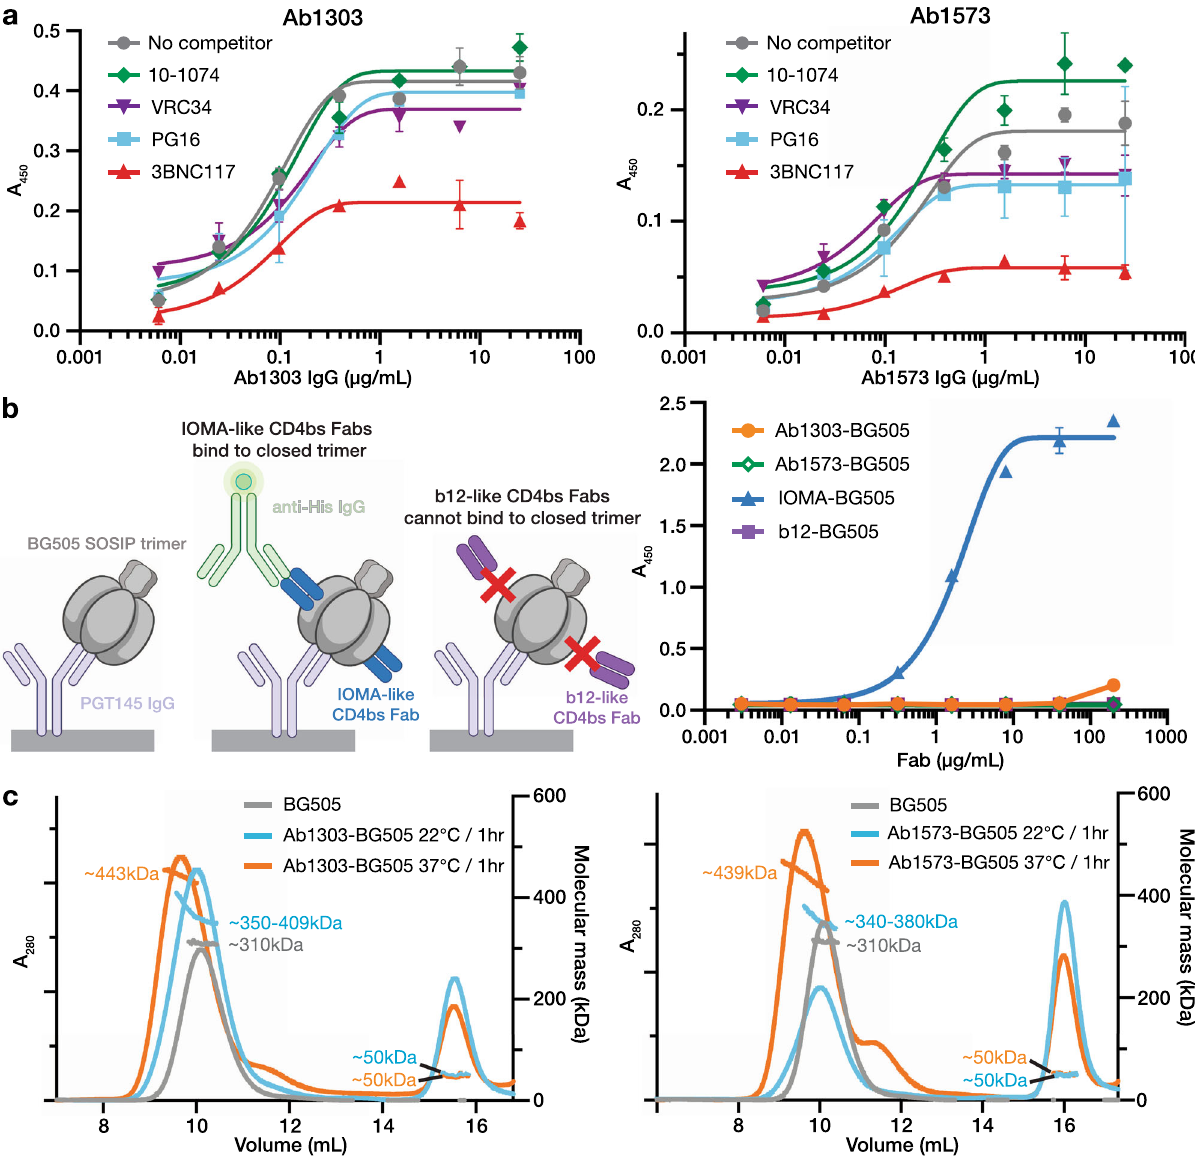
Fig. 1 Ab1303 and Ab1573 are CD4bs NAbs that bind an Env conformation other than the closed, prefusion state. a Competition ELISA to map the binding sites of Ab1303 (left) and Ab1573 (right) on BG505 SOSIP. Randomly biotinylated BG505 SOSIP trimer was immobilized on a streptavidin plate and then incubated with a Fab from a bNAb that recognizes the V3 loop (10-1074, green, diamonds), the fusion peptide (VRC34, purple, inverted triangles), the V1V2 loop (PG16, blue, squares), or the CD4bs (3BNC117, red, triangles). Increasing concentrations of Ab1303 or Ab1573 IgG were added to the Fab-BG505 complex, resulting in competition in both cases with the CD4bs bNAb 3BNC117. Data represents mean ± s.d. from n = 2 biologically independent samples. Source data are provided as a Source Data fi le. b ELISA to assess binding of Ab1303 and Ab1573 to closed, prefusion conformation of BG505 trimer. Left: schematic of the experiment: PGT145 IgG (light purple), which constrains BG505 to a closed prefusion conformation, was immobilized and captured BG505 (gray). Binding of His-tagged Fab (blue or dark purple) to BG505 was detected using a labeled anti-His-tag antibody (light green). Representation is created with BioRender.com. Right: Ab1303 (orange), Ab1573 (green), and b12 (dark purple) do not bind to BG505 captured by PGT145, but IOMA (blue) binds to BG505 captured by PGT145. Data represents mean ± s.d. from n = 2 biologically independent samples. Source data are provided as a Source Data fi le. c SEC-MALS of Ab1303-BG505 (left) and Ab1573-BG505 (right) complexes incubated at different temperatures. SEC traces were monitored by absorption at 280 nm. Traces and estimated molecular mass distributions for unliganded BG505 (gray) and for Ab1303 Fab or Ab1573 Fab incubated with BG505 SOSIP trimer at 37 °C (orange) or 22 °C (blue) for 1 h are shown. ELISA experiments conducted with RC1 trimer 19 , this time using BG505 trimer (Fig. 1a). We fi rst immobilized randomly- biotinylated BG505 Env trimers on streptavidin plates and then added antibody Fabs targeting either the CD4bs (3BNC117) 16 , the V3-glycan patch (10-1074) 29 , V1V2 (PG16) 30 , or the fusion peptide (VRC34) 31 . Subsequently, either Ab1303 or Ab1573 IgGs were added, the plates were washed, and the degree of binding VRC34 Fabs also reduced the binding somewhat (Fig. 1a). From NATURE COMMUNICATIONS| (2022) 13:732